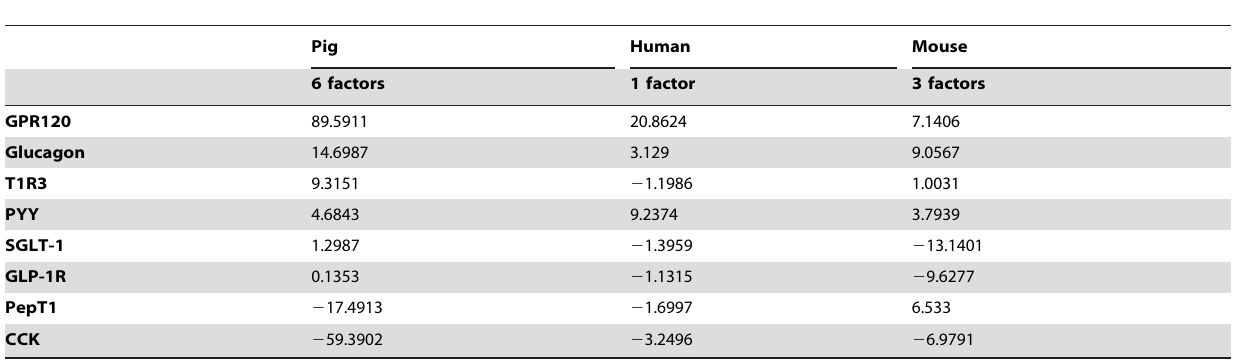
Loading vectors obtained from PLS modeling of the small intestinal data set of pig, human and mouse. doi:10.1371/journal.pone.0107531.t002 PLOS ONE |